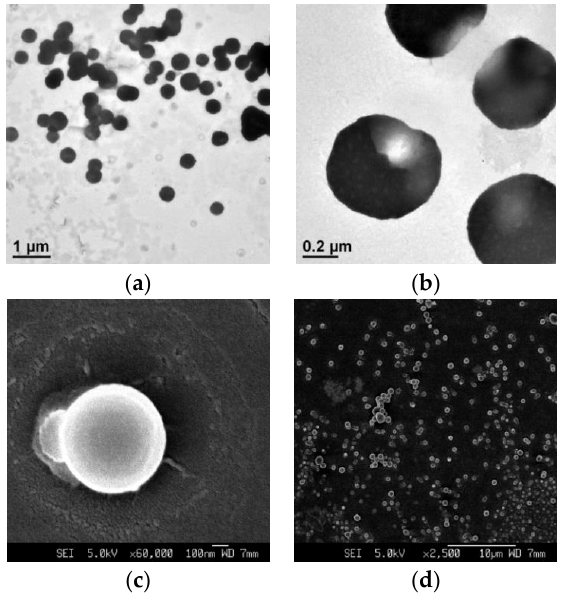
Figure 3. Negative-stained TEM images ( a ) scale bar = 1 μm and ( b ) scale bar = 0.2 μm and gold sputtering SEM images ( c ) scale bar = 10 μm and ( d ) scale bar = 100 nm about the vesicular assemblies by the inclusion X2 ⸧ G1 (1 × 10 −3 mol L −1 ). Reproduced with permission from [15]. Copyright Royal Society of Chemistry, 2013.